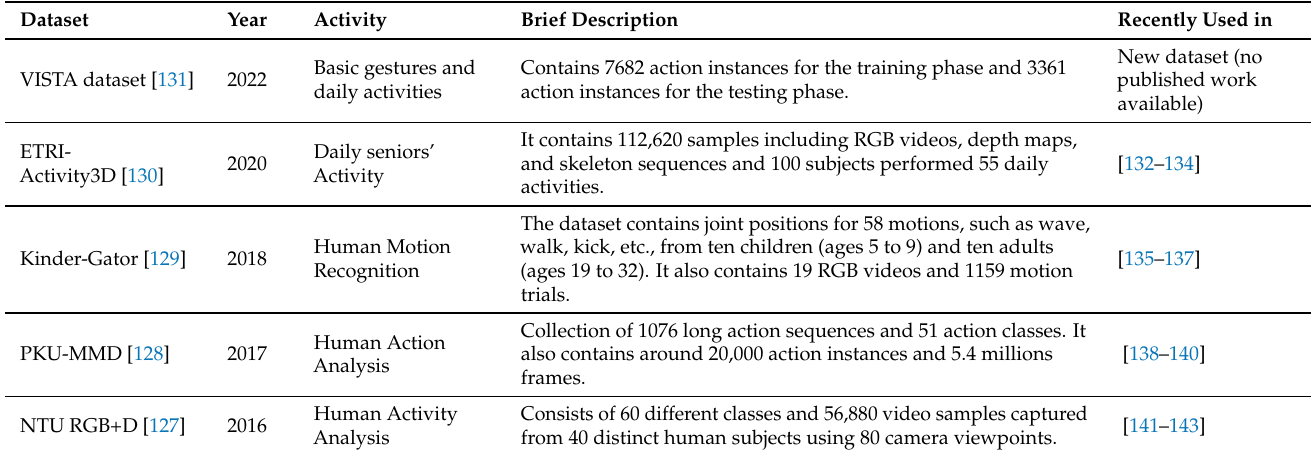
Table 5. Overview of the in-home health dataset using depth sensor from the last